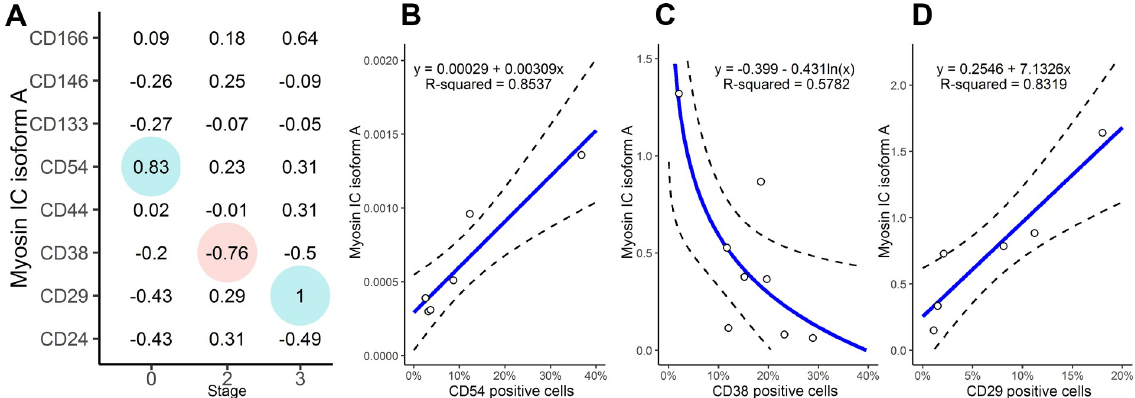
Fig 4. Prostate cells with low and high myosin 1C isoform A expression exhibit different surface phenotypes. A—Spearman correlation coefficients between myosin 1C isoform A expression and percentages of positive cells for indicated surface markers at different disease stages. Significant correlations (p < 0.05) are marked by color. B–D—Least-squares regression between myosin 1C isoform A and percentage of CD54 (B), CD38 (C) and CD29 (D) positive cells. The approximation and coefficient of determination are included. Dashed line shows the 95% confidence